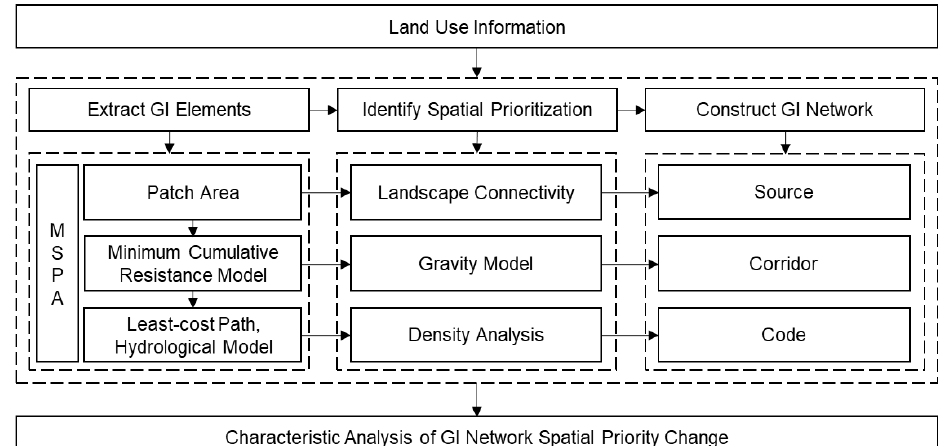
Figure 3. The technical flowchart of this study.